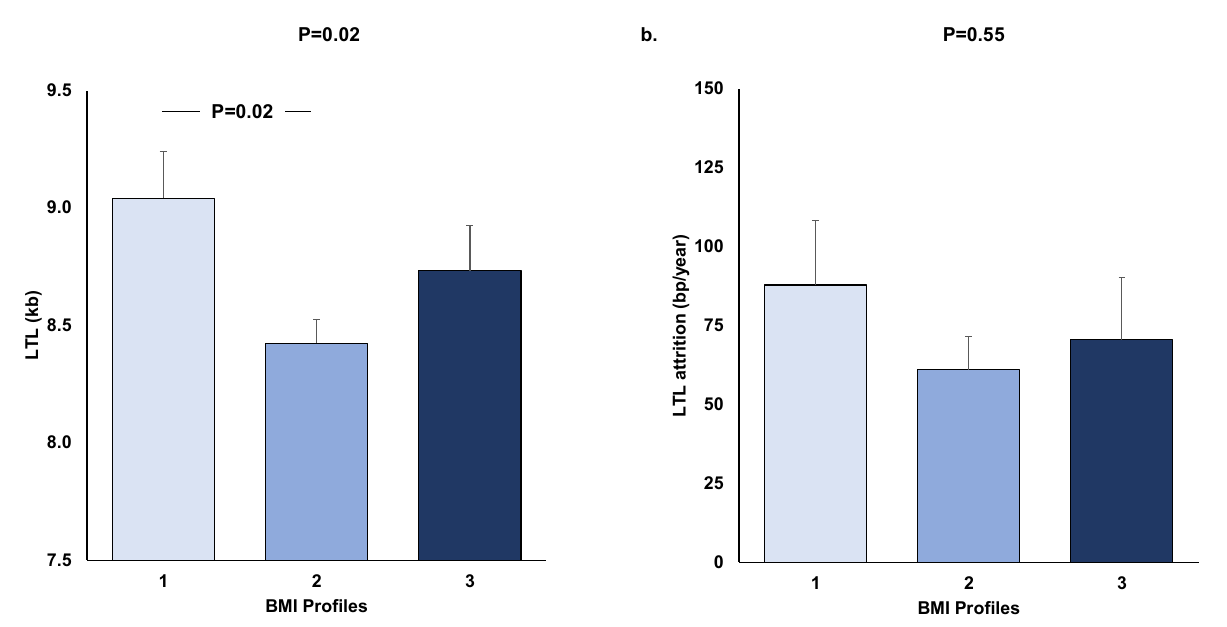
Figure 2. Baseline LTL ( a ) and LTL attrition ( b ) in the three BMI profiles.LTL values were age- and sex-adjusted, and LTL attrition values were age-, sex-, and initial LTL-adjusted. Values are expressed as means ± SEM, and p is derived from ANOVA. Tukey–Kramer post hoc test was used for two-by-two comparisons. LTL = leukocyte telomere length; kb = kilobase; BMI = body mass index; bp = base pair.